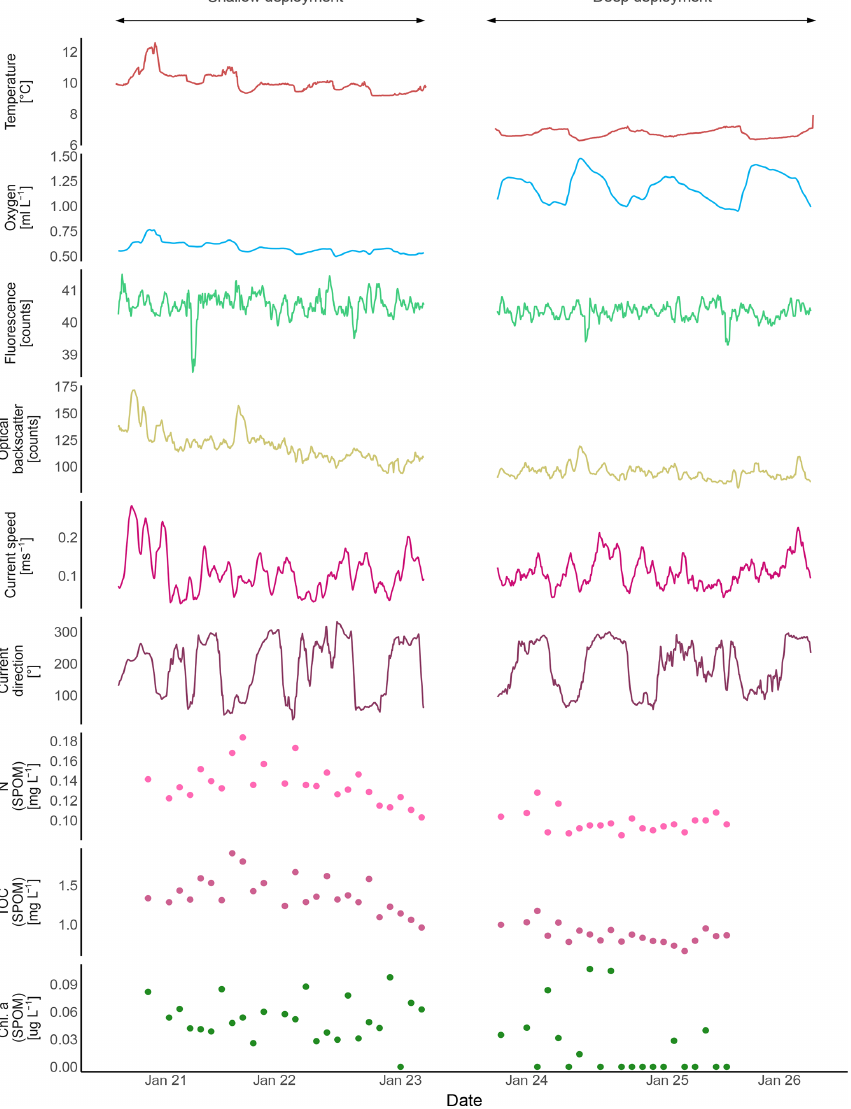
Figure 7. Lander data (ALBEX) recorded during at the shallow ( ∼ 340m water depth) and deep sites ( ∼ 530m water depth) off Angola (January 2016). Shown are temperature ( ◦ C; red), dissolved oxygen concentration (mLL − 1 ; blue), fluorescence (counts per second; green), optical backscatter (turbidity; yellow), current speed (m s − 1 ; pink) and current direction ( ◦ : 0–360 ◦ ; purple) as well as nitrogen (mgL − 1 ; pink dots), carbon (mgL − 1 ; purple dots), and chlorophyll a concentration (µgL − 1 , green dots) of SPOM collected during the both deployments by the McLane